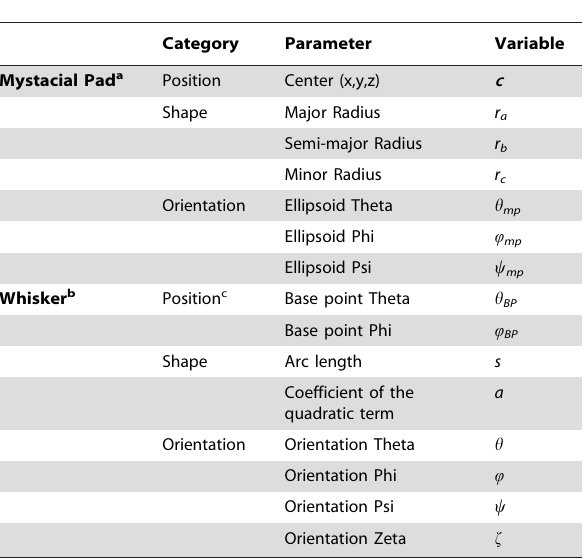
Table 1. Vibrissal array